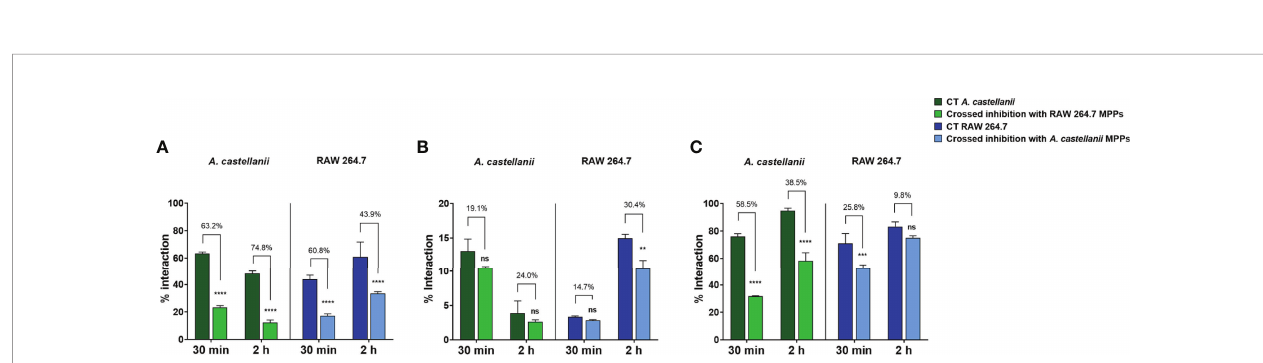
FIGURE 5 | Mannose puri fi ed proteins (MPPs) of Acanthamoeba castellanii and RAW 246.7 macrophages co-localized with a mannose-speci fi c lectin Concanavalin A. Fluorescence microscopy images demonstrate the cell wall of the fungi (A) Candida albicans ; (B) Cryptococcus neoformans and (C) Histoplasma capsulatum stained in blue (Uvitex 2B); MPPs of phagocytes stained in green upon incubations with yeasts, followed by the streptavidin-Alexa 488 conjugate; and the mannosylated components of the yeast cell wall stained in red, after incubations with ConA-TRITC. Scale bar= 5 m m.